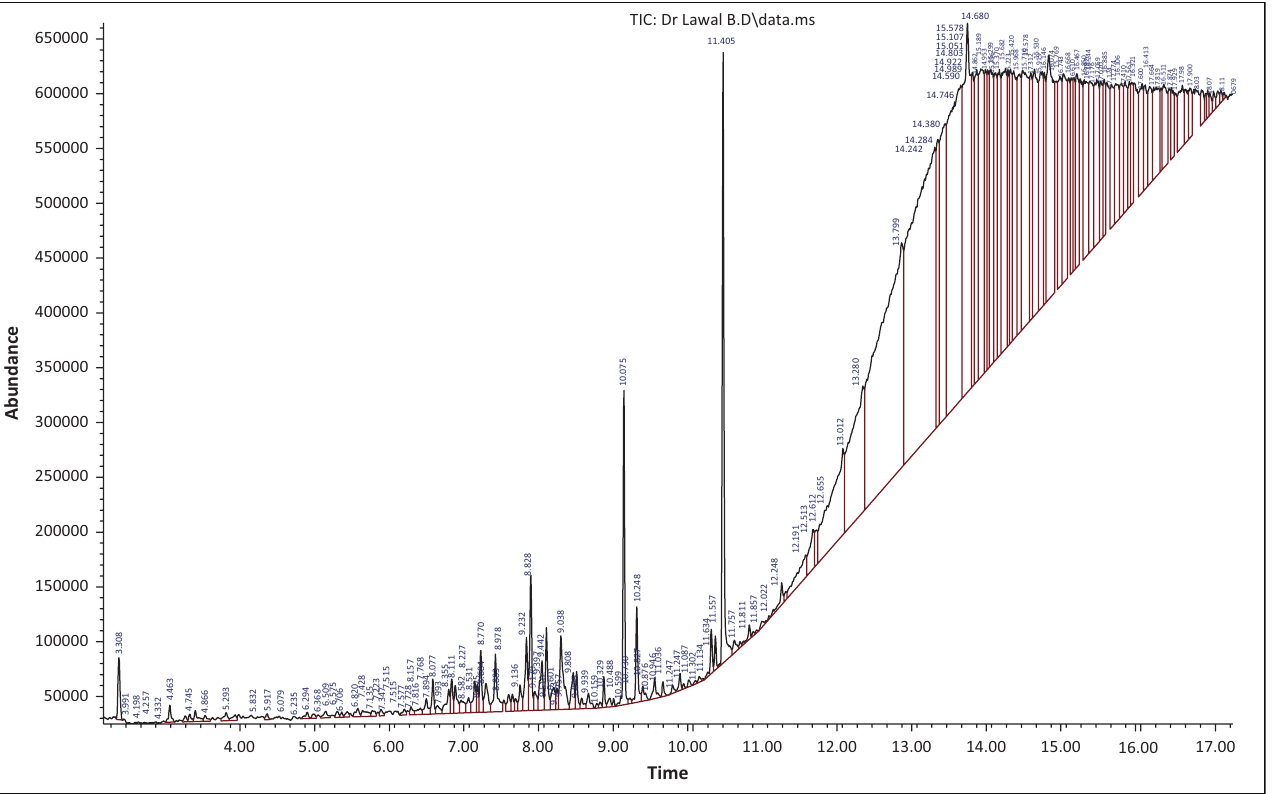
FIGURE 2: Gas chromatography–mass spectroscopy spectral data of Clausena anisata essential oil using the solvent-free microwave